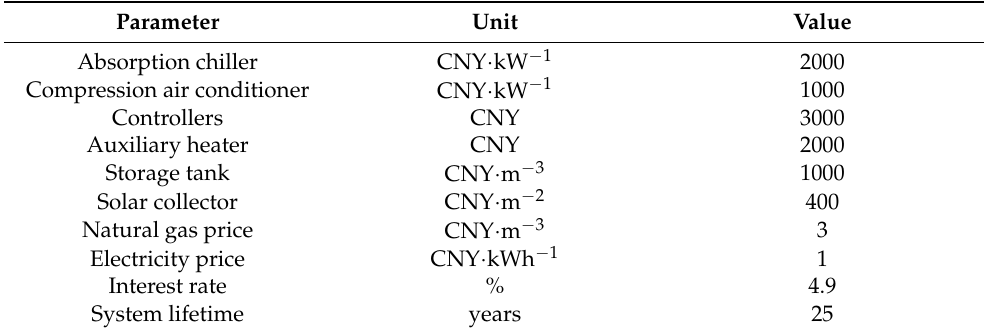
Table 1. Parameters value of economic